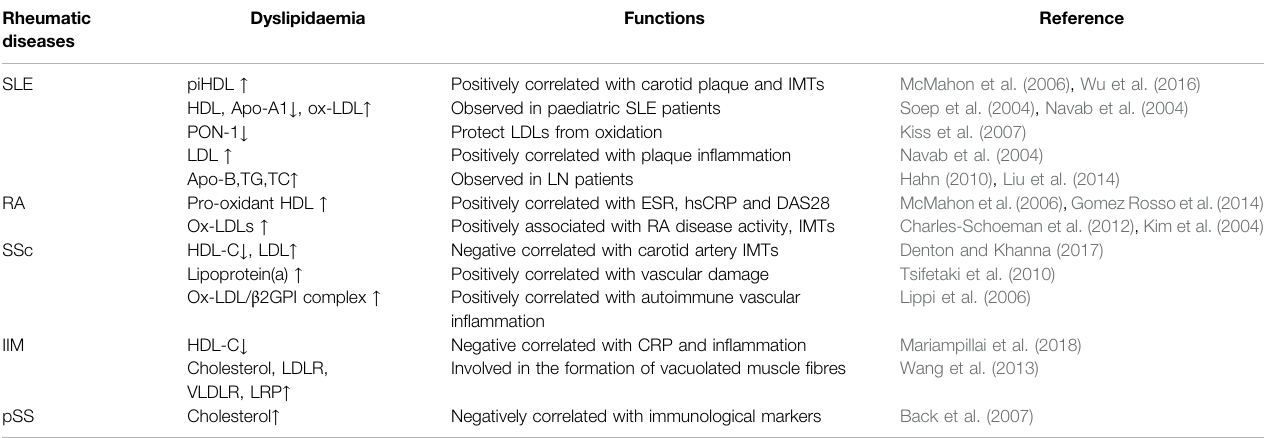
TABLE 1 | Dyslipidaemia in rheumatic